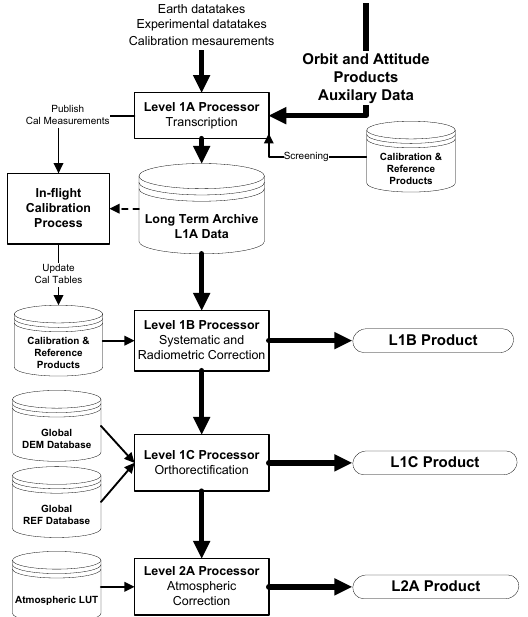
Figure 4. DESIS automatic processing chain and